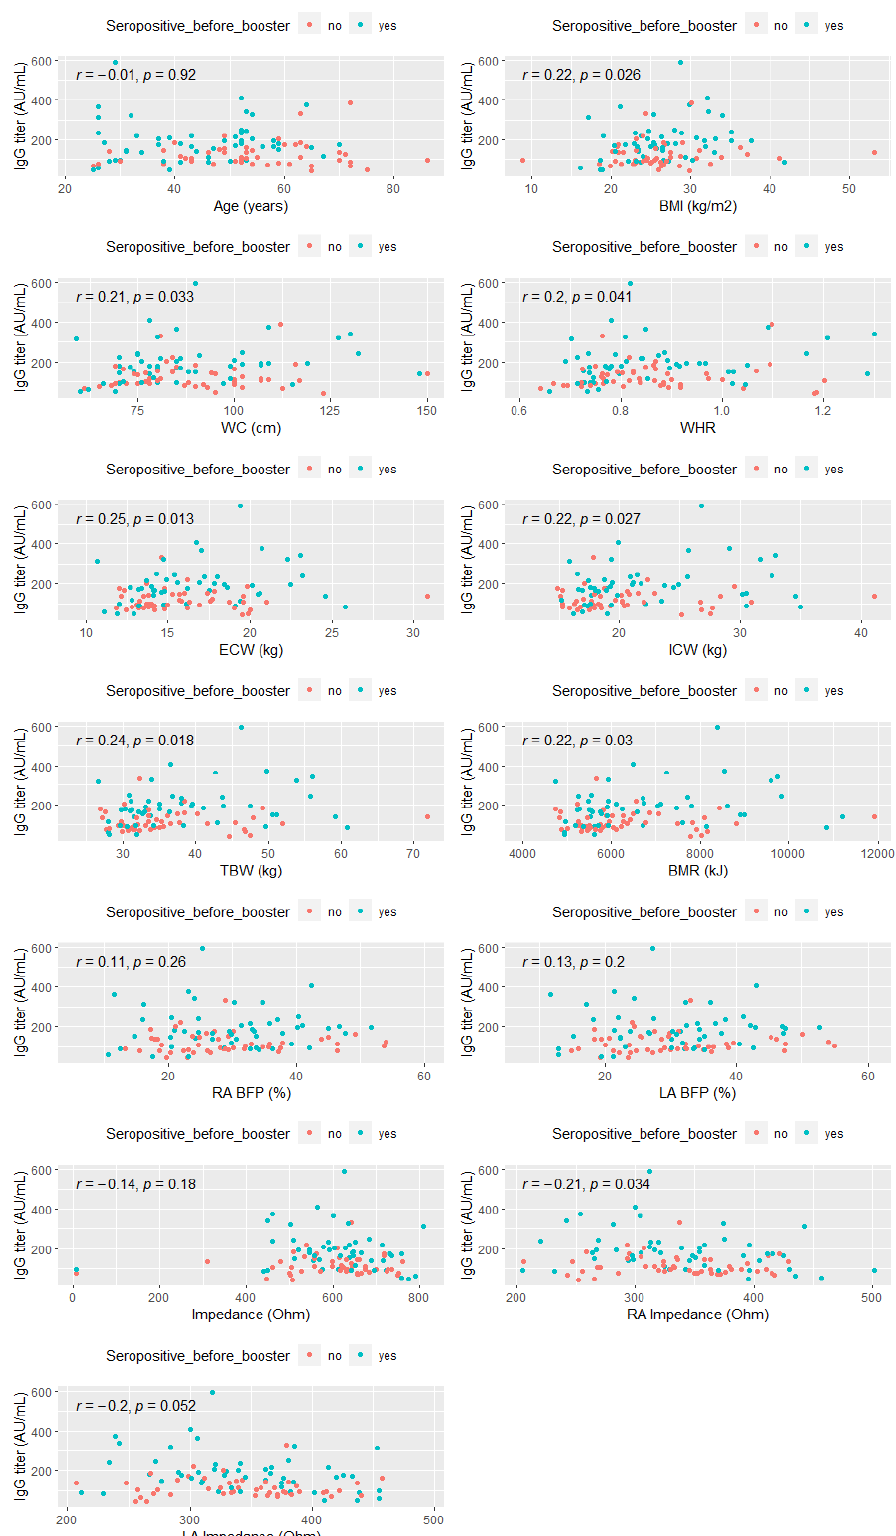
Figure 3. Spearman correlation between anti-SARS-CoV-2 IgG titers and selected anthropometric parameters and derived ratios and body composition parameters. Abbreviations: BMI—body mass index, WC—waist circumference, WHR—waist-hip ratio, TBW—total body water, ICW—intracellular water, ECW—extracellular water, BMR—basal metabolic rate, RA Impedance—right arm impedance, LA Impedance—left arm